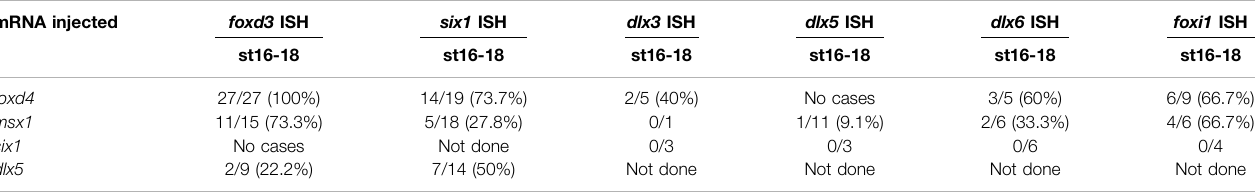
TABLE 2 | The number of cases in which cells distant from the lineage label showed reduced expression at neurula stages. mRNA